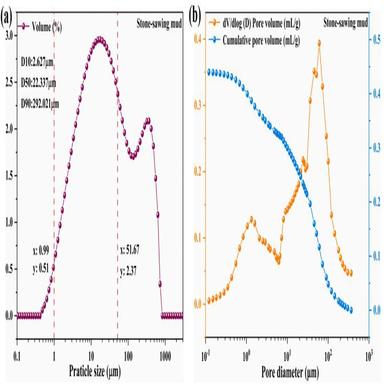
(a) Particle size distribution of SSM and (b) pore size distribution and cumulative pore volume of sintered SSM.